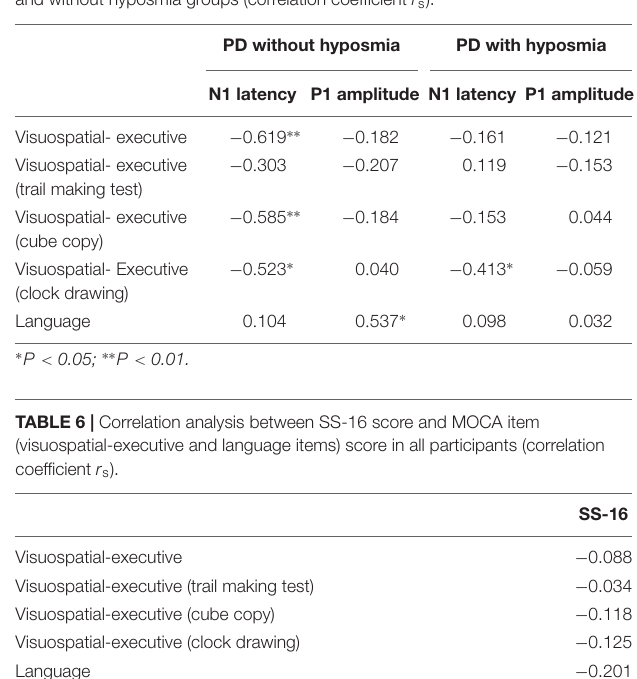
TABLE 5 | Correlation analysis between parameters of ERP components (N1 and P1) and MOCA item (visuospatial-executive and language items) score in PD with and without hyposmia groups (correlation coefficient r s ).